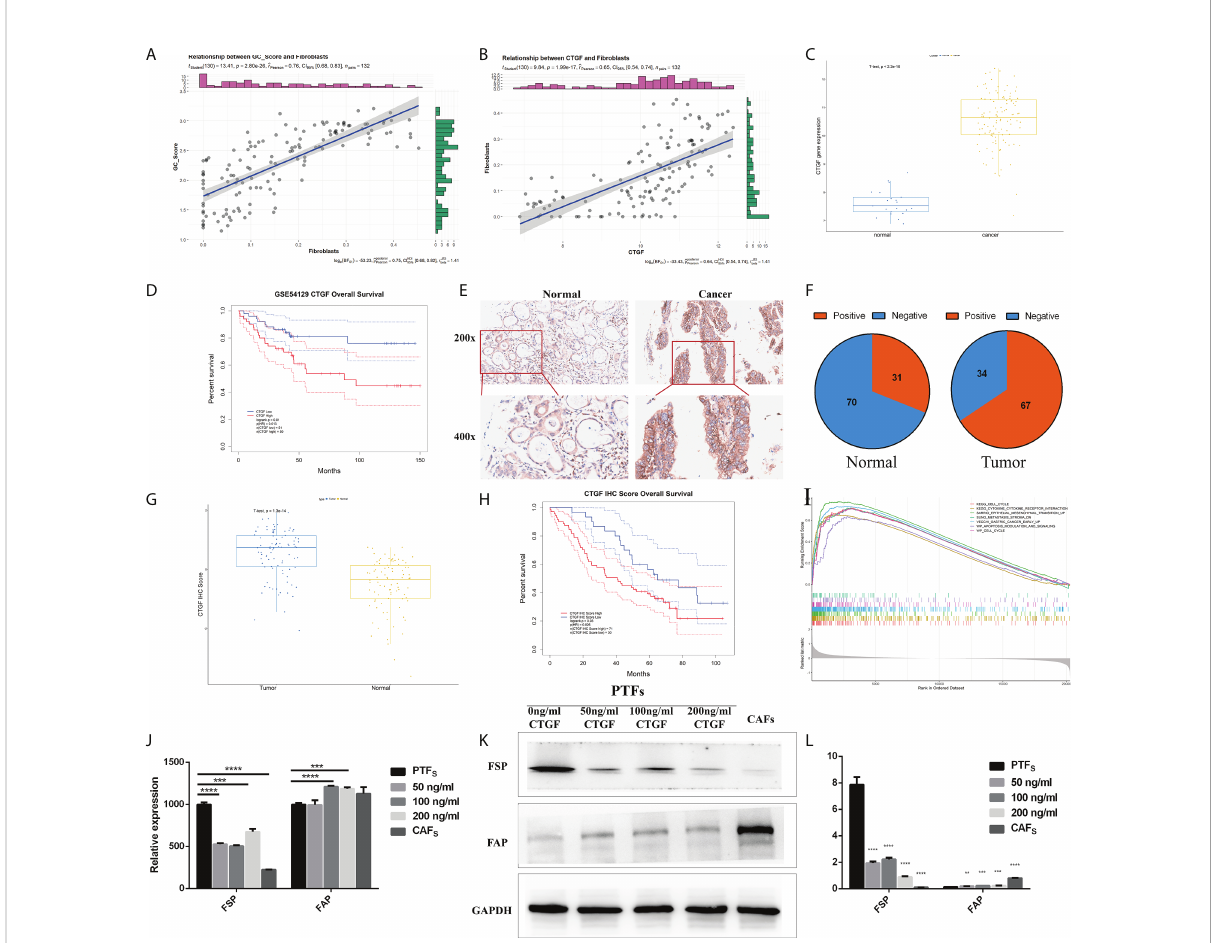
FIGURE 6 CTGF has the potential to induce PTFs to be CAFs. (A, B) Correlations between GC_Score and fi broblasts/CTGF and fi broblasts. The regression lines and con fi dence interval shadows were calculated by single-variable regression. (C) The boxplot of the CTGF expression in normal and cancer samples. The thick line represented the median value. The bottom and top of the boxes were the 25th and 75th percentiles (interquartile range). (D) Survival impact of the CTGF expression, Kaplan – Meier curves for overall survival (OS) in the GSE54129 cohort. (E) Representative IHC staining with CTGF antibody in GC and paired adjacent non-tumor tissues. Magni fi cation ×200 and ×400. (F) The pie graph of IHC Score of CTGF in GC tissues and corresponding non-tumor tissues, Positive: IHC ≥ 8, Negative: IHC <8. (G) The boxplot of IHC Score of CTGF in normal and cancer samples. The thick line represented the median value. The bottom and top of the boxes were the 25th and 75th percentiles (interquartile range). (H) Survival impact of IHC Score of CTGF, Kaplan – Meier curves for OS. (I) Gene set enrichment analysis (GSEA) of CTGF. (J) qRT-PCR detection of FSP and FAP mRNA levels in PTFs, CAFs, and PTFs treated with different concentrations of rhCTGF protein for 50, 100, and 200 ng/ml. (K, L) Protein levels of FSP and FAP in PTFs, CAFs, and PTFs treated with different concentrations of rhCTGF protein were analyzed by Western blotting. These data were presented as the mean ± SD; n = 3 independent